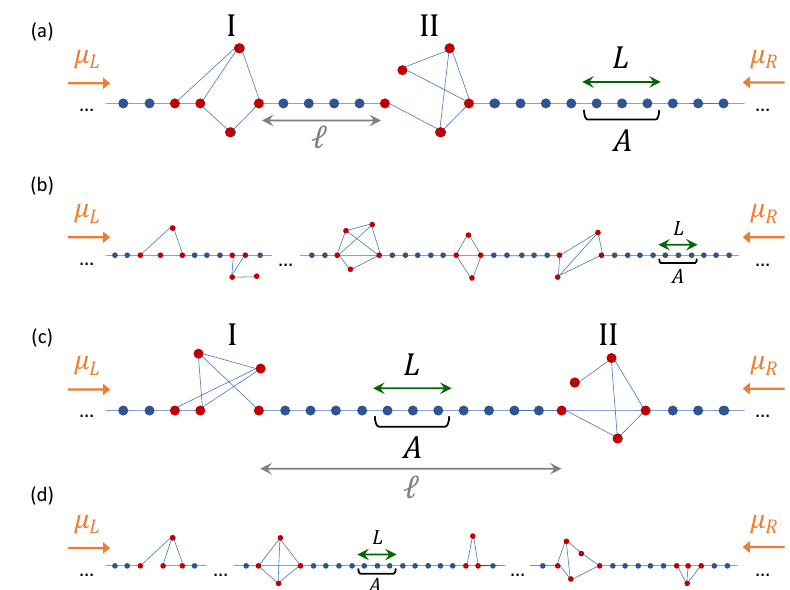
Figure 8: Schematic illustrations of the lattice models containing multiple scattering regions, which are discussed throughout Sec. 5. Sites marked in blue belong to the unperturbed parts of the tight-binding chain, while sites marked in red belong to the scattering regions. µ ( µ ) designates the chemical potential for particles incoming L R from the left (right). A denotes the subsystem of L contiguous sites with respect to which the calculations of bipartite entanglement are performed. Panel (a) depicts a scenario where two scattering regions are located on the same side of A . Panel (b) depicts a more general scenario with multiple scattering regions, that are all on the same side of A . Panel (c) depicts a scenario where A is located between two scat- tering regions. Panel (d) depicts an example for the general scenario, with multiple scattering regions on both sides of A . In (a) and (c), (cid:96) denotes the number of sites between scattering regions I and II, which is assumed to be much larger than the Fermi